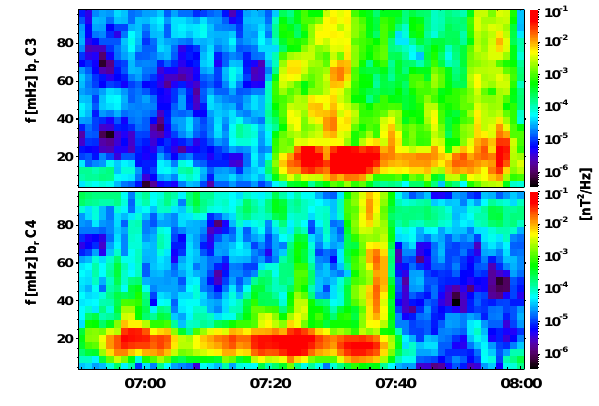
Fig. 8. Dynamic spectra of the radial magnetic field components b r of the spacecraft C3 (top) and C4 (bottom)